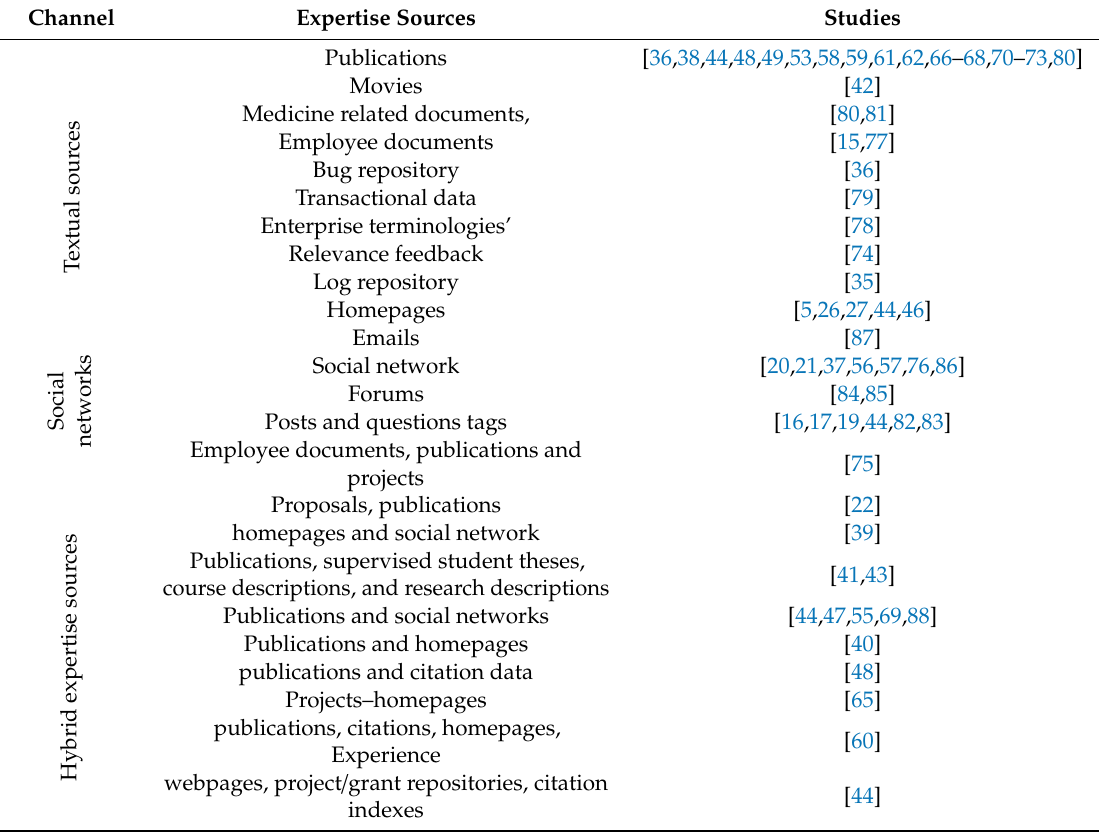
Table 4. Expertise